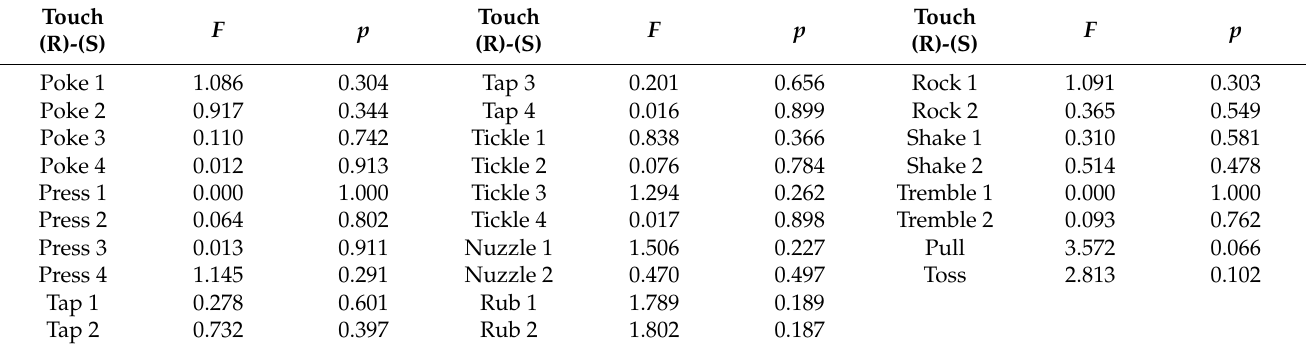
Table 4. Results of differences in perceiving between a receiver (R) and a sender